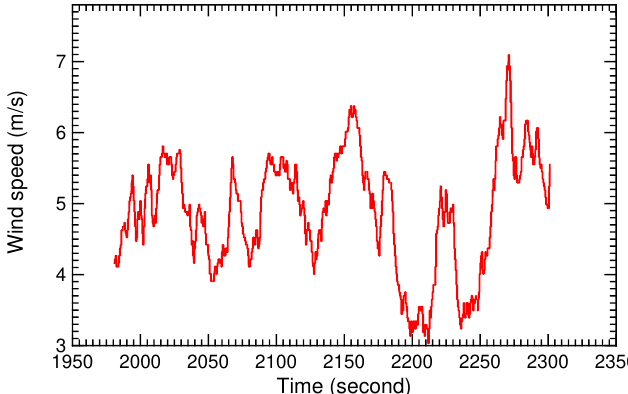
Figure 28. Recorded ground wind speed for two pumping